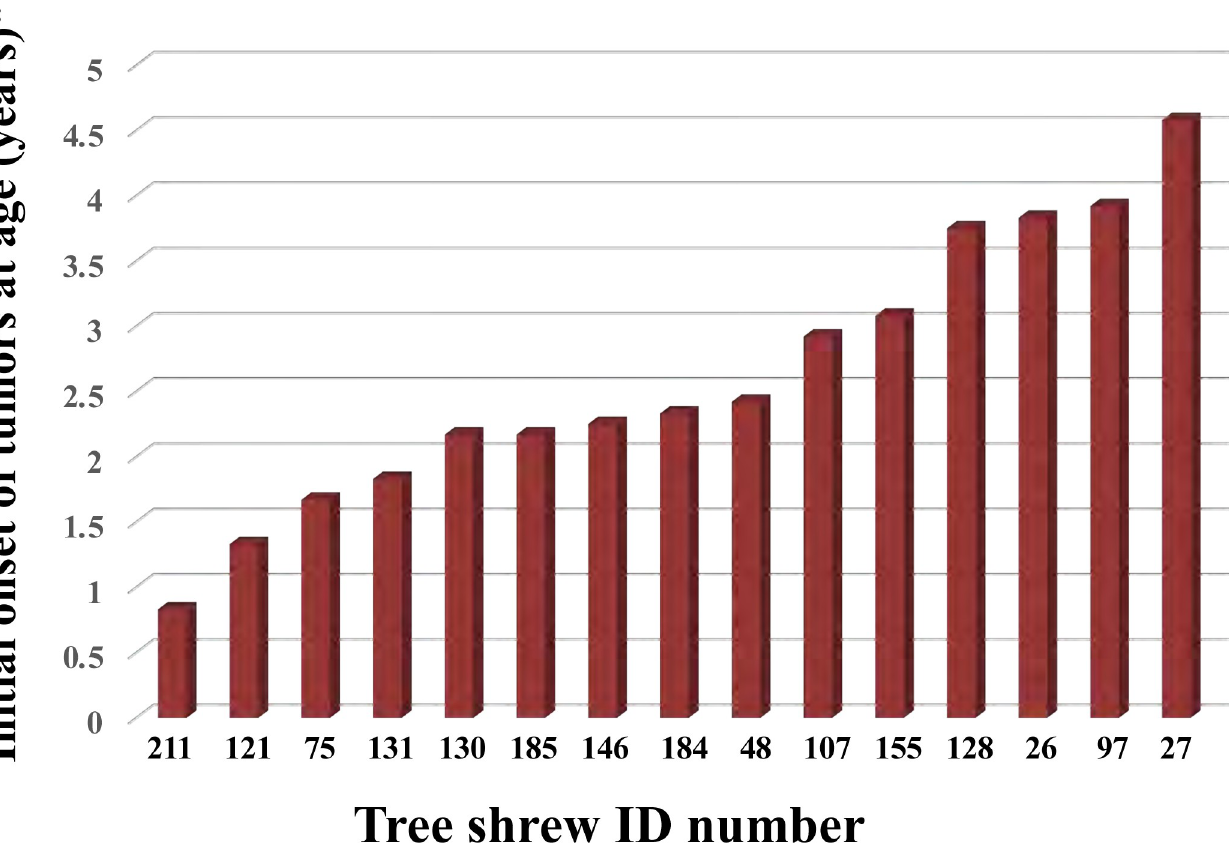
Fig 1. Onset of mammary tumors in female tree shrews was indicated. Initial onset age of spontaneous mammary tumors in tupaia is indicated. Each tupaia ID number is indicated on the horizontal